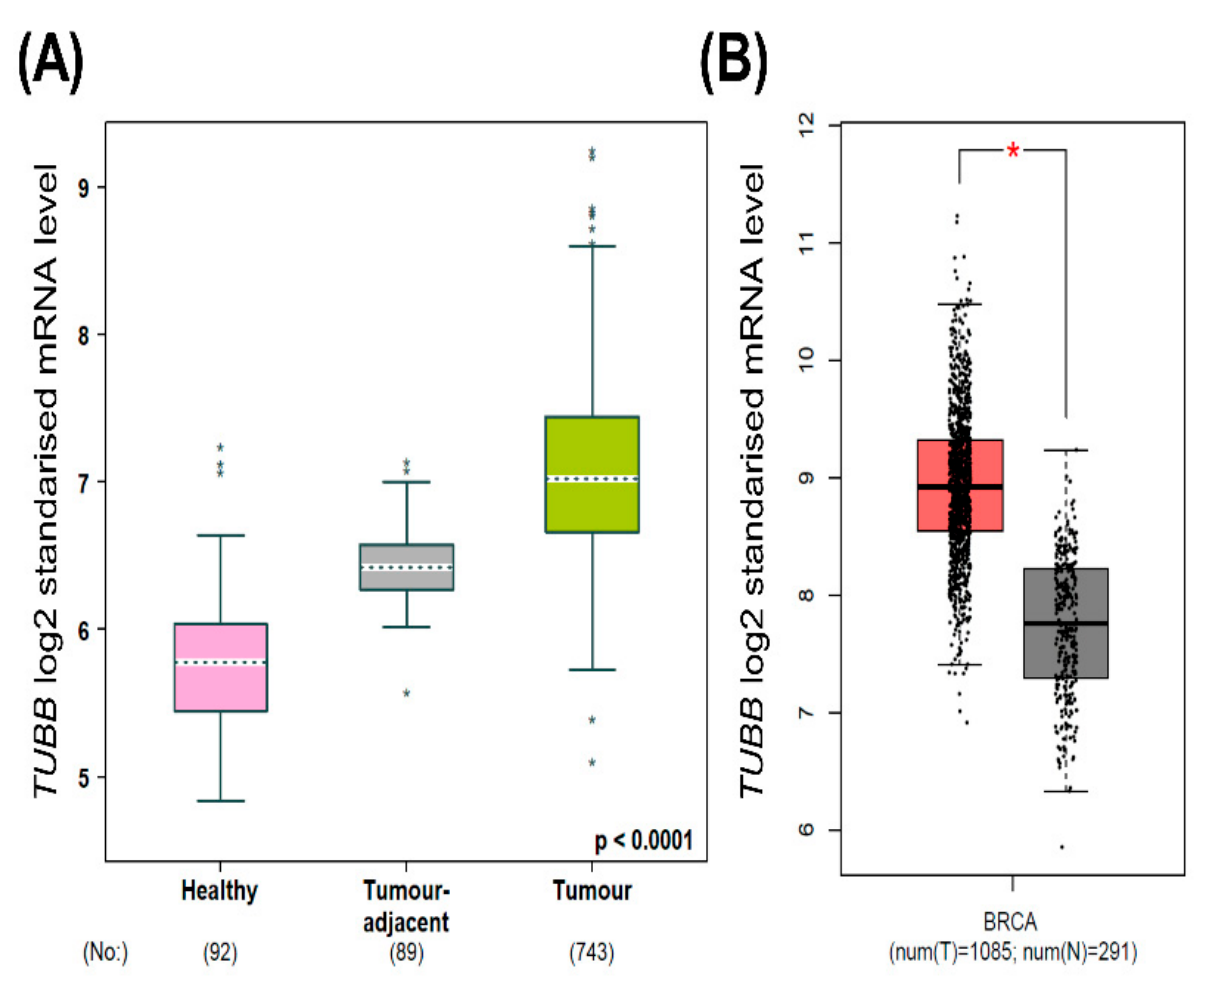
Figure 1. ( A ) Shows TUBB mRNA expression in normal, tumor-adjacent, and breast cancer tissues using bc-GenExMiner; ( B ) shows TUBB mRNA expression in normal and breast cancer tissue using GEPIA. * p < 0.05.